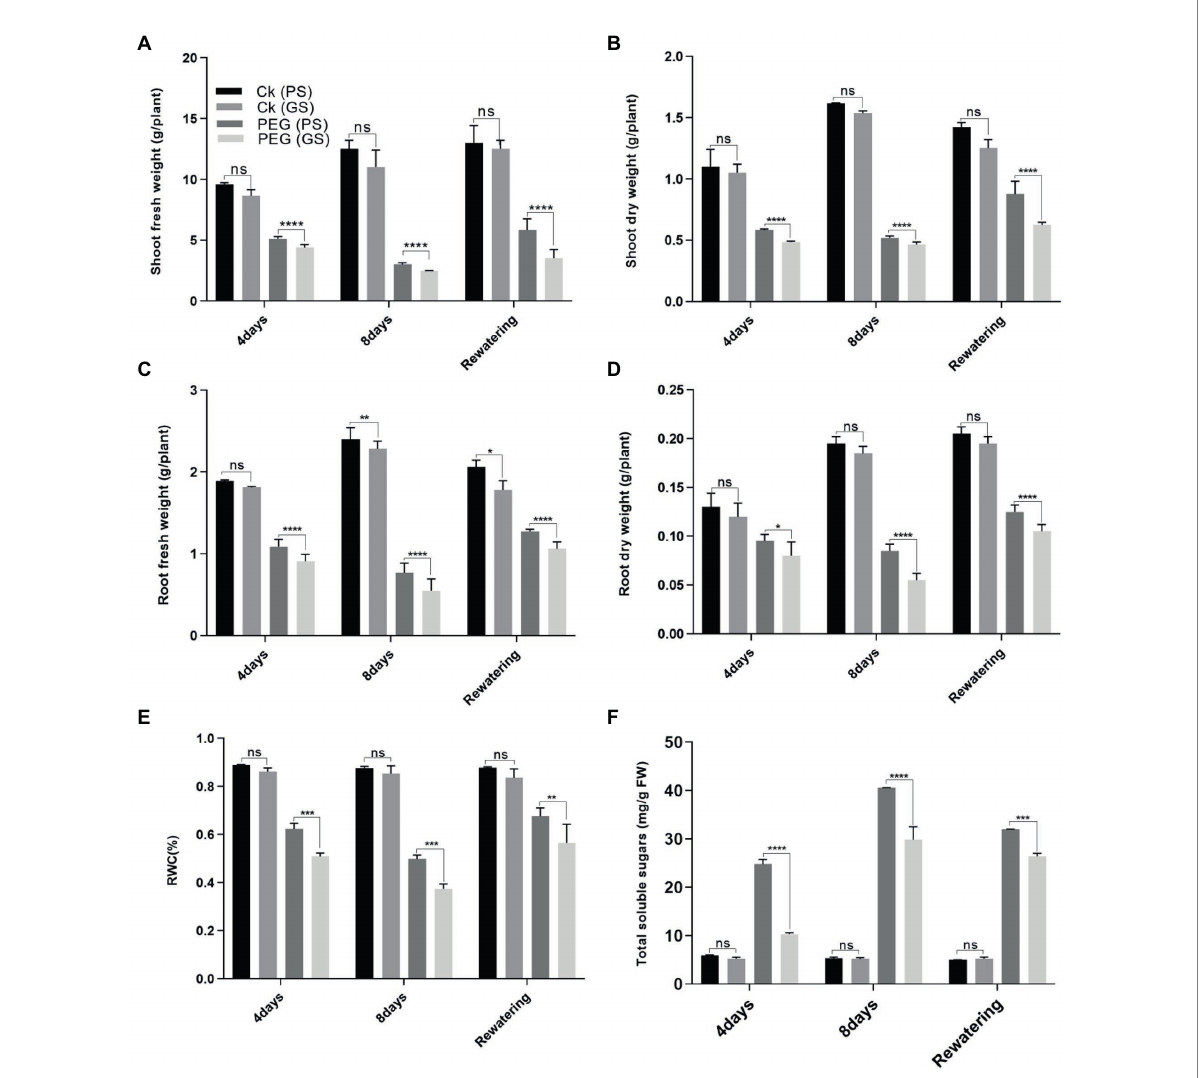
FIGURE 1 Purple and green stem Brassica napus plants growth and morphology under drought (10% PEG-6000), (A) shoot fresh weight, (B) shoot dry weight, (C) root fresh weight, (D) root dry weight, (E) relative water content (RWC), and (F) total soluble sugars, respectively. Different symbols represent significance level as * p = 0.05, ** p = 0.01, *** p = 0.001, **** p = 0.0001. ns,